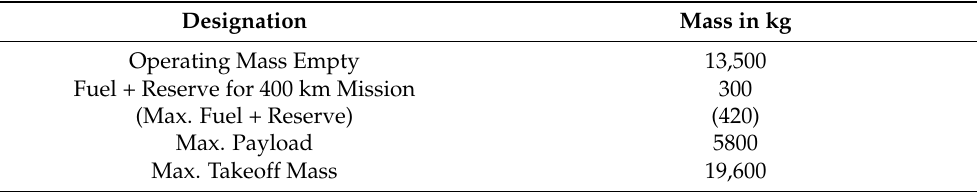
Table 13. Aircraft